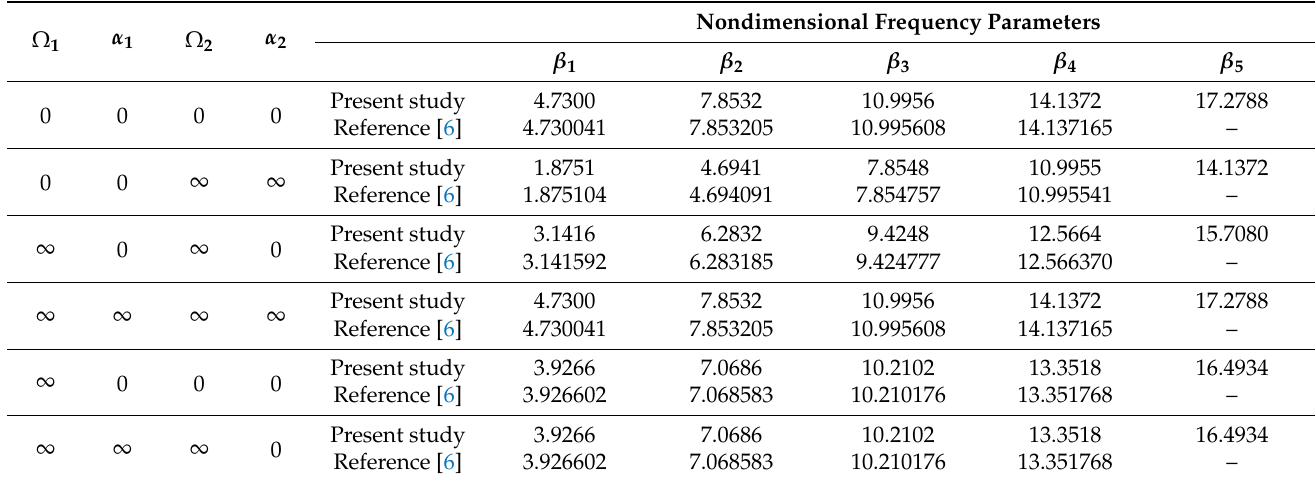
Table 1. The obtained first five nondimensional frequency parameters for standard cases.